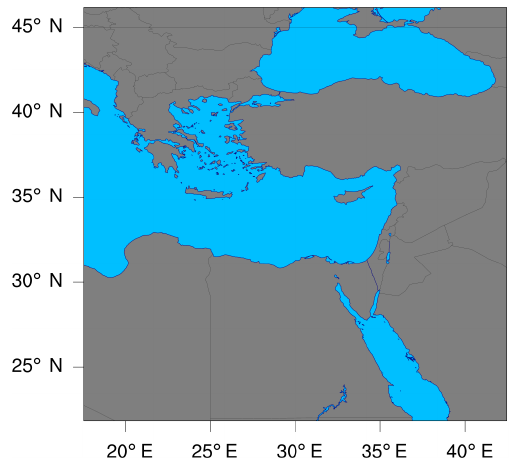
Figure 6. The geographic domain utilized during the WRF-Chem simulations conducted in this study. The domain extends between 17.6 and 42.4 ◦ E in the longitudinal direction, and between 21.9 and 46.1 ◦ N in the latitudinal